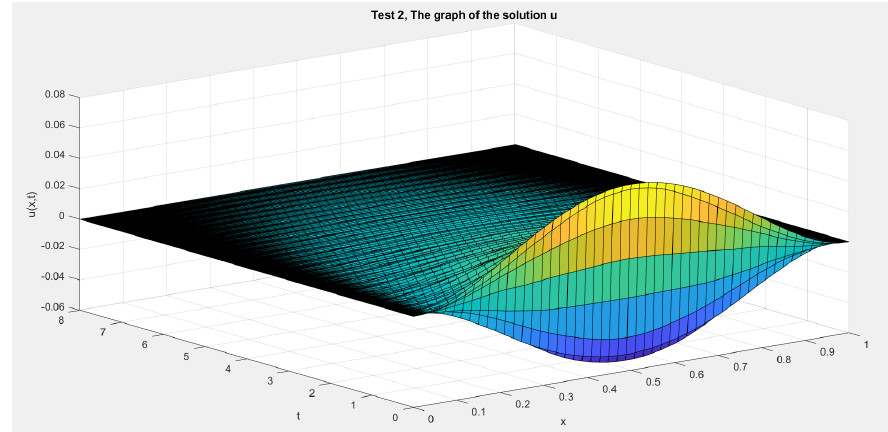
Figure 9. Test1: The solution u ( x , t ) .